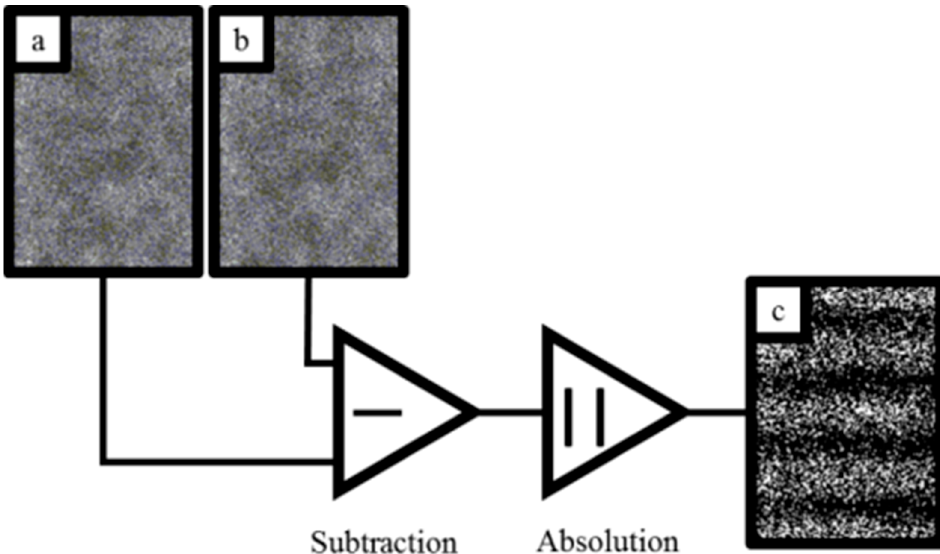
Figure A2. Optical system of 2D-ESPI.